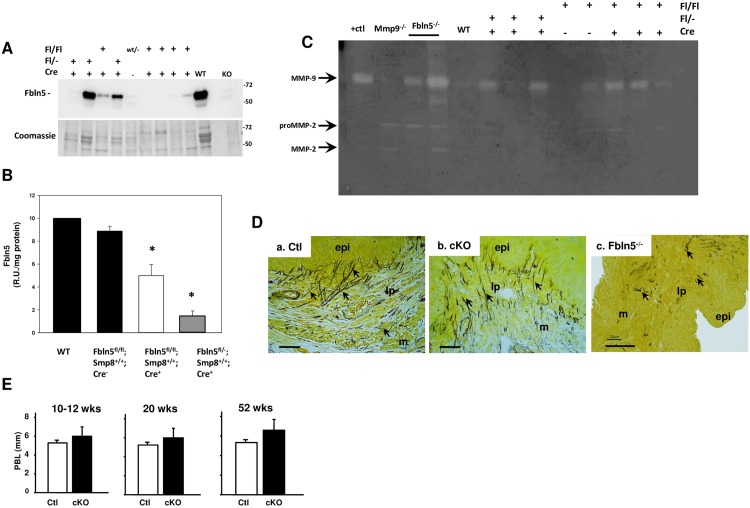
Expression of Fbln5 in targeted mice.rtTA/Fbln5f/f/SMA++/Cre-, rtTA/Fbln5f/-/SMA/Cre+, or rtTA/Fbln5f/f/SMA++/Cre+ mice were treated with doxycycline as outlined in Materials and Methods. Thereafter, Fbln5 was quantified in the fibromuscular layer of the vaginal wall. A. Representative immunoblot and coomassie stained protein gel. B. Quantification of Fbln5 in vaginal urea extracts from Fbln5f/f/SMA++/Cre- (n = 7, solid bar), Fbln5f/f/SMA/Cre+ (n = 9, open bar), or Fbln5f/-/SMA++/Cre+ (n = 7, grey bar) normalized to protein content. Tissue extracts from wild type (WT) animals were used as a standard on each gel. *p < 0.05 compared with Cre- animals, ANOVA followed by Dunnett’s test using WT as control. C. Gelatin zymography of soluble protein extracts from Fbln5f/f/SMA++/Cre-, Fbln5f/-/SMA/Cre+, or Fbln5f/f/SMA++/Cre+. Purified proMMP (+ctl), protein from Fbln5-/-, and Mmp9-/- vaginal tissues were used as positive and negative controls. D. Hart’s stain of mid-vagina from Fbln5f/f/SMA++/Cre- (a. Cre-) or Fbln5f/f/SMA++/Cre+ (b. Cre+) mice in basal conditions. Vaginal wall from age-matched Fbln5-/- mouse shown in c (Fbln5-/-). Arrows indicate elastic fibers. epi, vaginal epithelium; lp, lamina propria; m, muscularis. Bar = 40 μm. Note decreased magnification in c to illustrate paucity of fibers. E. Effect of Fbln5 cKO on spontaneous development of prolapse as a function of age. Perineal body length was measured at 10–12, 20, and 52 weeks of age in Fbln5f/f/SMA++/Cre- (Ctl, n = 3) and Fbln5f/f/SMA++/Cre+ (cKO, n = 4) mice. Magnitude of bulge did not differ among genotypes (not shown). All animals were treated with doxycycline at 6 weeks of age.